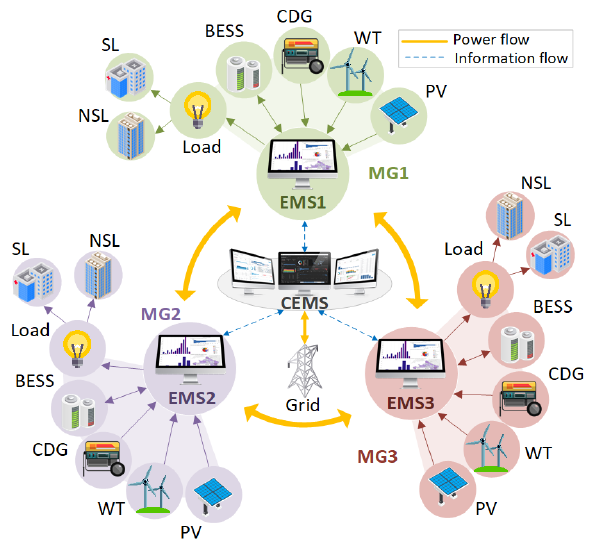
Figure 1. Proposed energy management